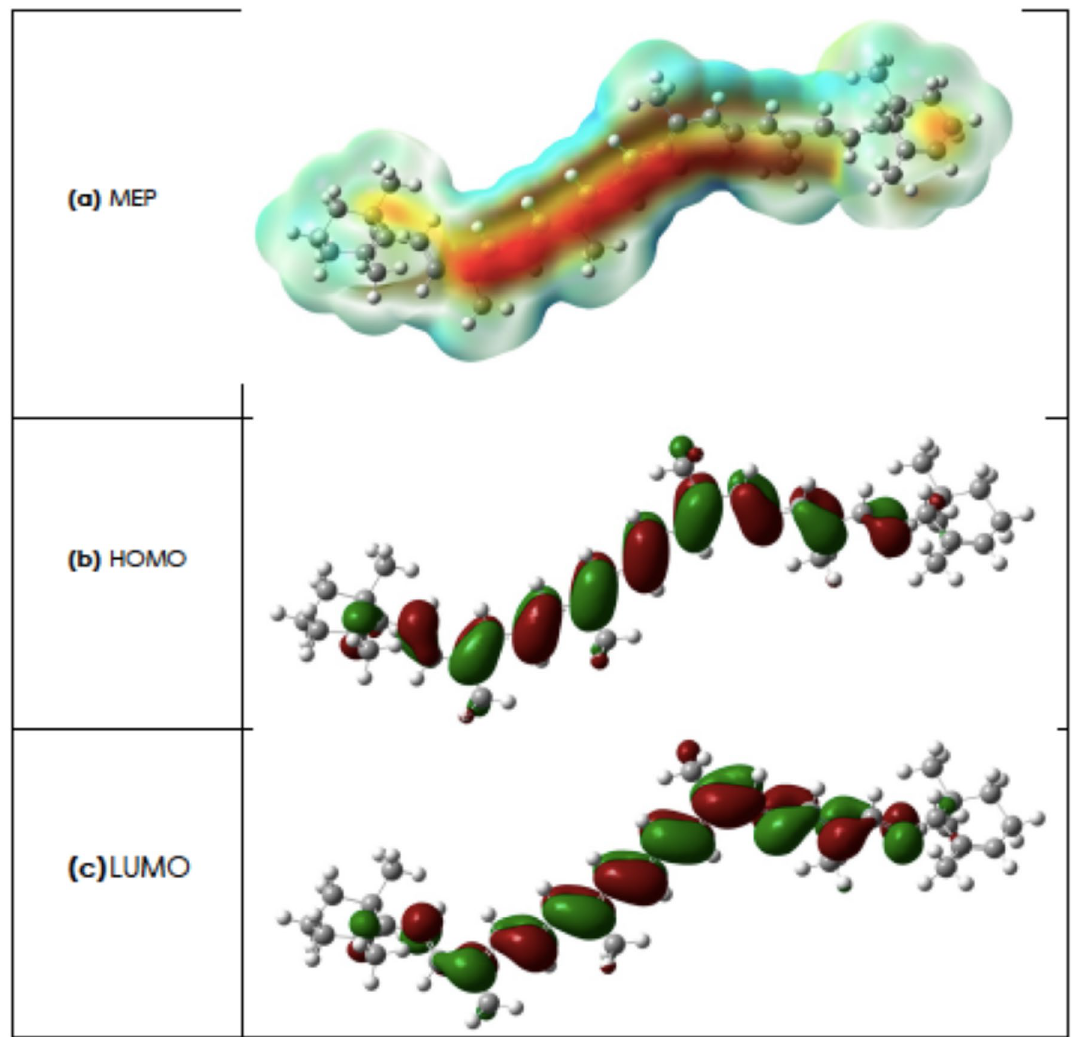
Figure 7. ( a ) Molecular Electrostatic Potential (MEP) of the optimized structure of Lycopene (the reddish regions indicate the most active sites of Lycopene, ( b ) The Highest Occupied Molecular Orbital (HOMO) and ( c ) the Lowest Unoccupied Molecular Orbital (LUMO), referred to as frontier orbitals.